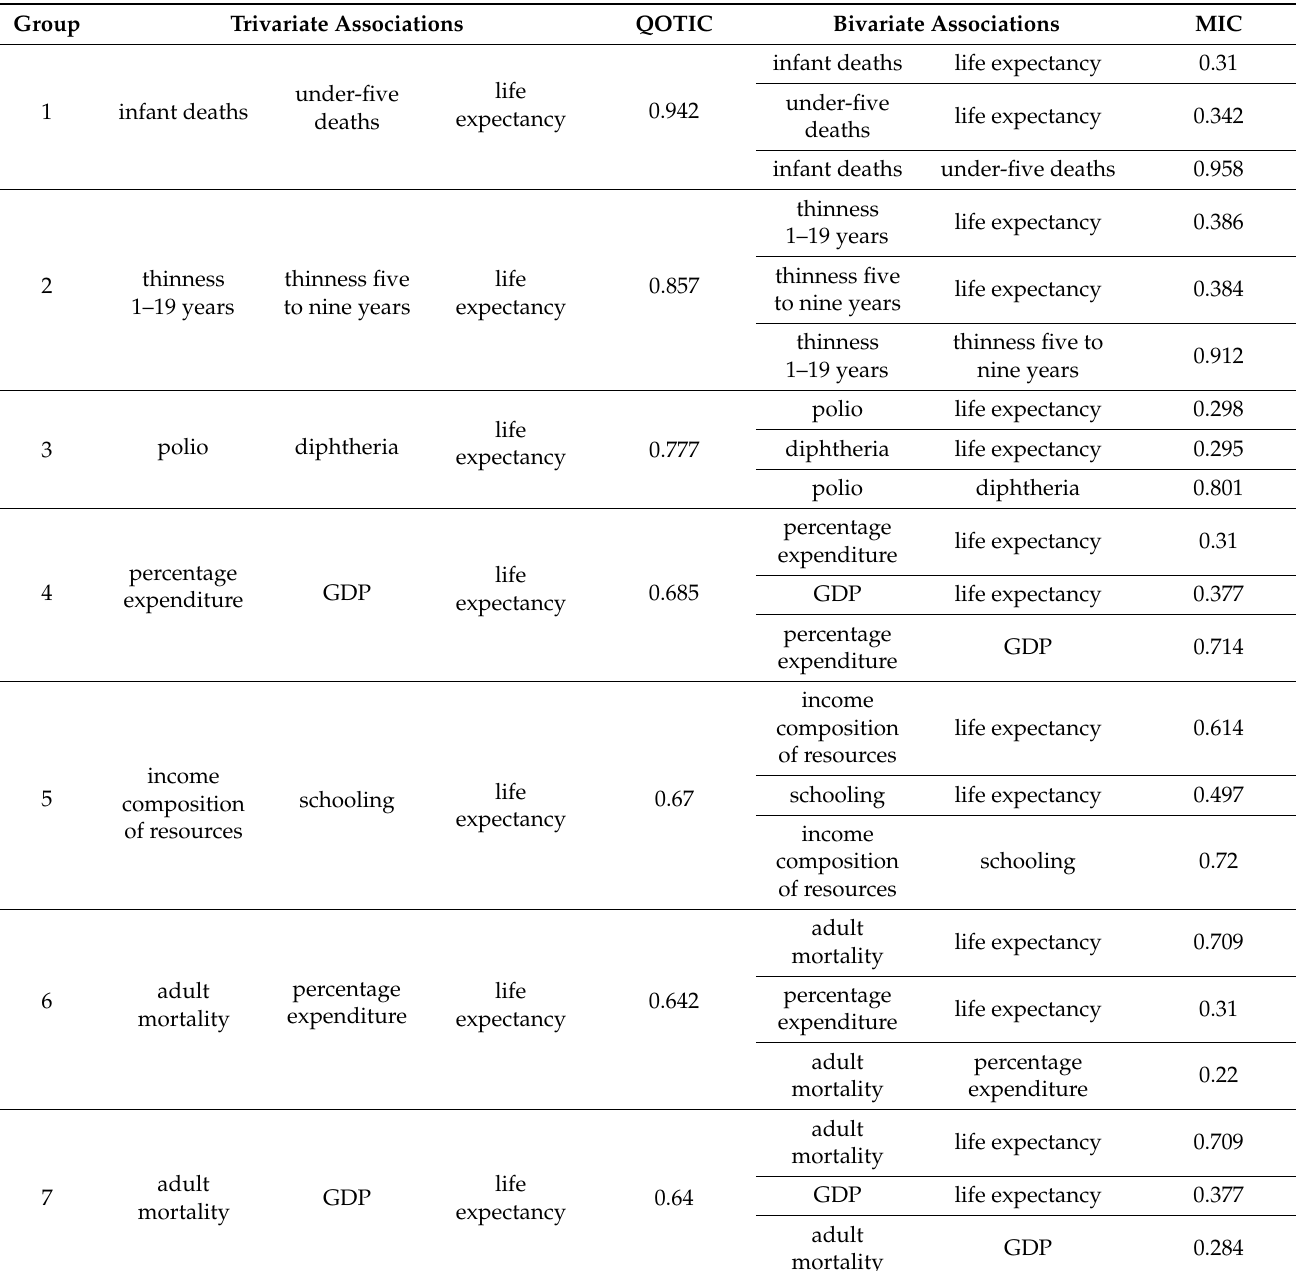
Table 5. Trivariate associations by QOTIC and Bivariate associations by